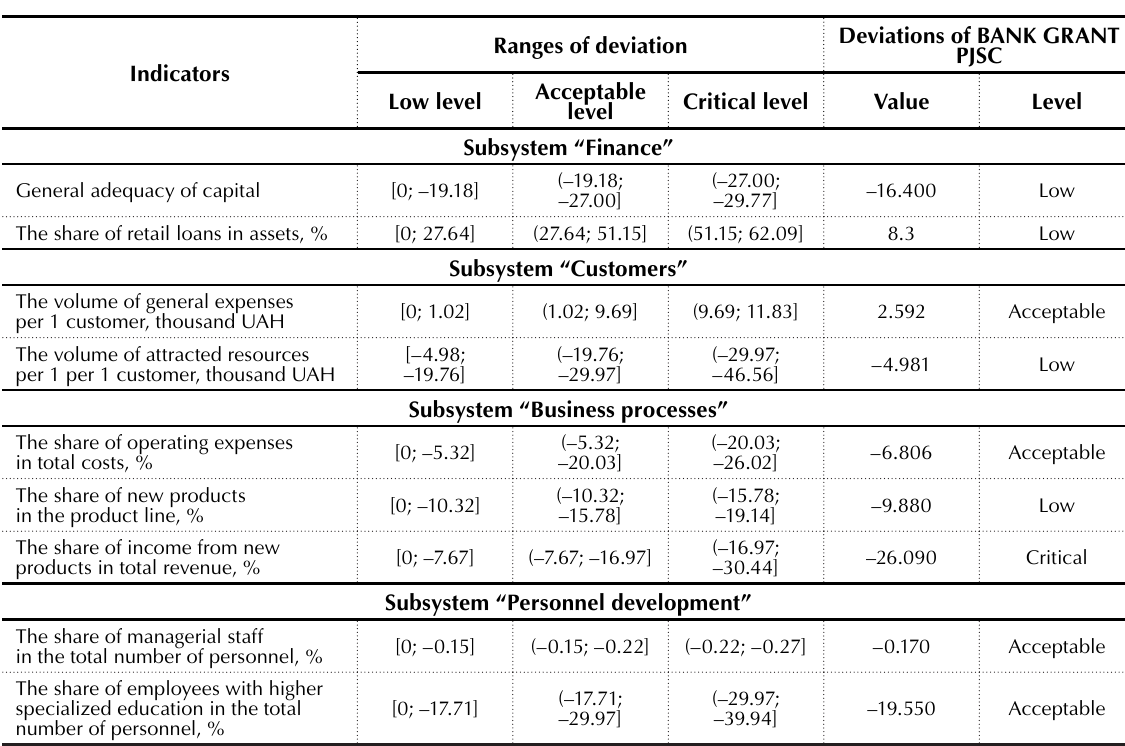
Table 4. Ranges of deviations of comparable indicators and their levels for BANK GRANT